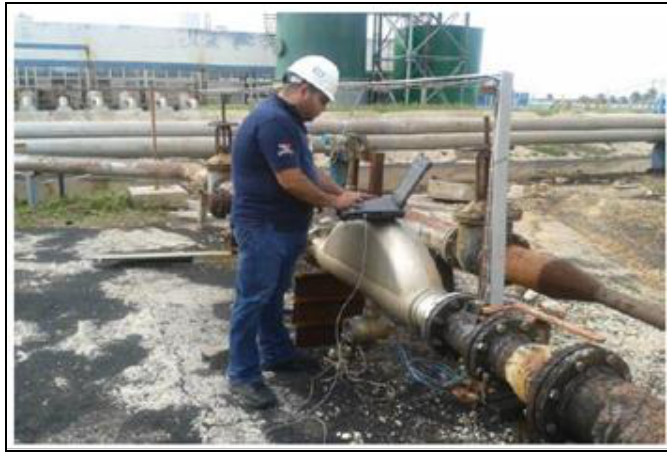
Figura 10: Flujómetro Coriolis instalado para la transferencia fiscal. Fuente: Los Autores,